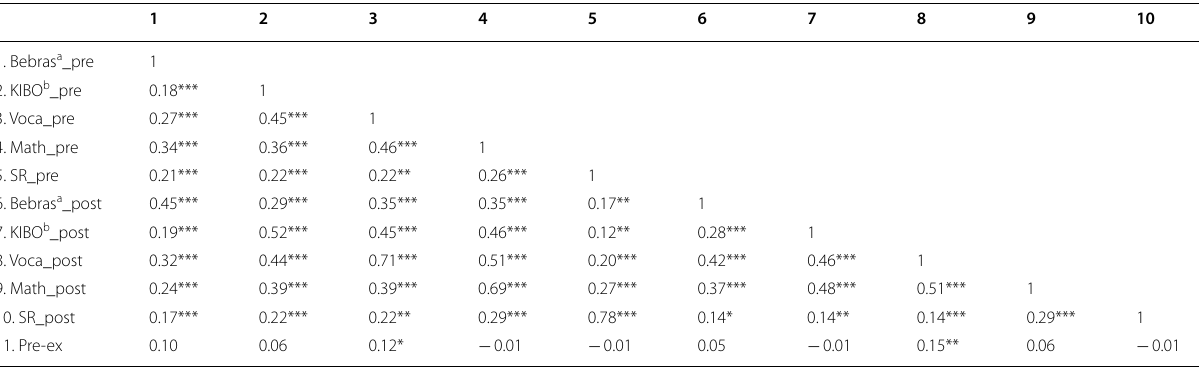
a Children’s CT ability without using a specific platform. b = SR Self-regulation and social behavior. Pre-ex = ** p < 0.01. *** p <